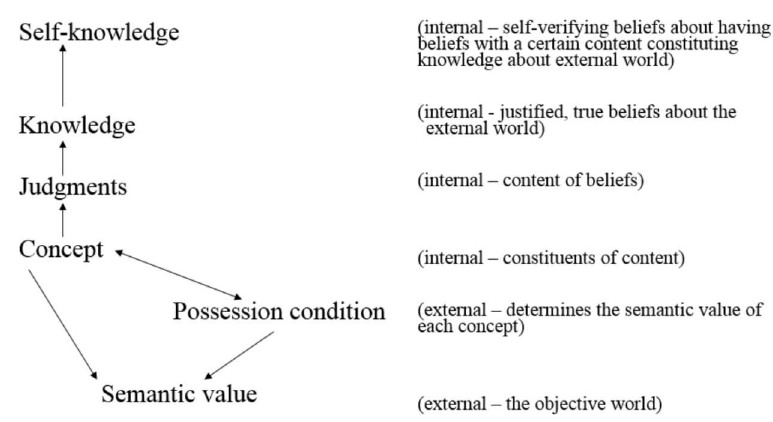
Figure 1. Peacocke’s Model of Self-knowledge